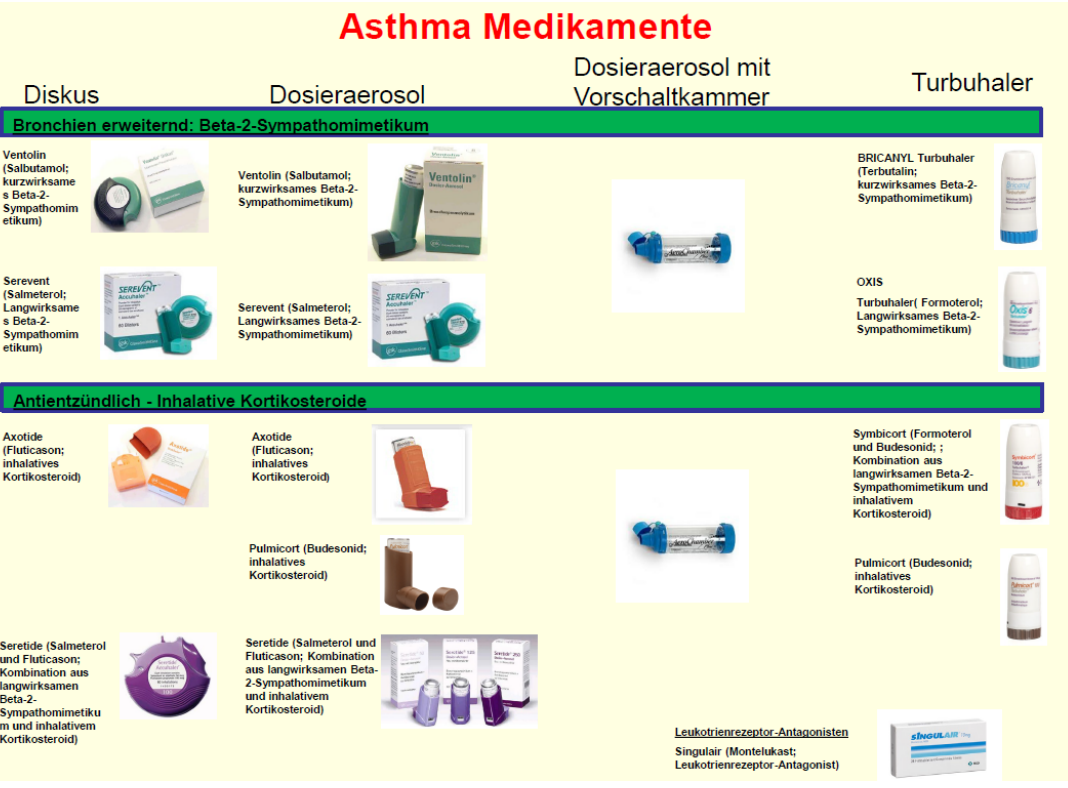
Figure S1: Poster of asthma medications used in the LuftiBus in the school (LUIS) study to help children answer which medication they had taken the day of the visit (in